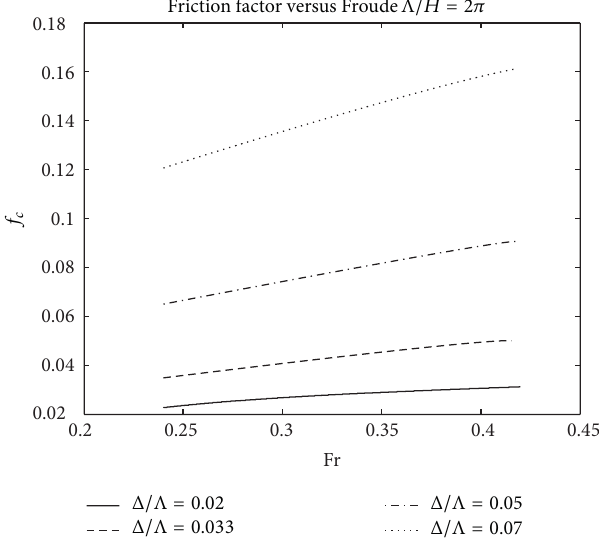
Figure 7: Comparison between measured [15] and calculated total shear stresses.